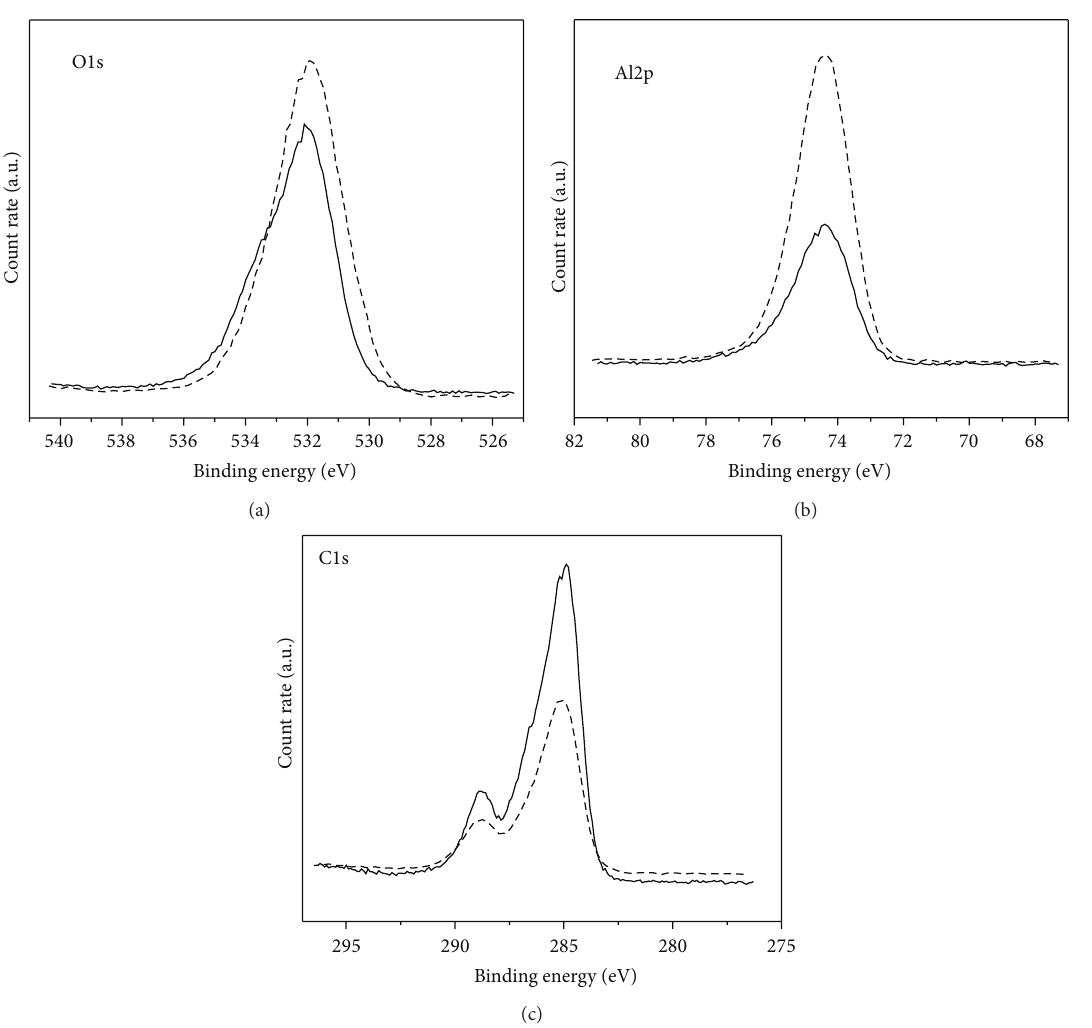
Figure 3: XPS detail spectra of untreated powder before deposition (solid line) and thick powder coating (dashed line). (a) O1s peak, (b) Al2p peak, and (c) C1s peak. Table 3: Binding energies (BE) of relevant peaks, particular concentration 𝑐 𝑥 , and measured relative area 𝐴 meas of carbon bonds within the C1s peak as well as literature values for 𝐴 lit of the untreated powder before deposition. Peak BE in eV 𝑐 in at.% 𝐴 meas in % 𝐴 lit in % [32]